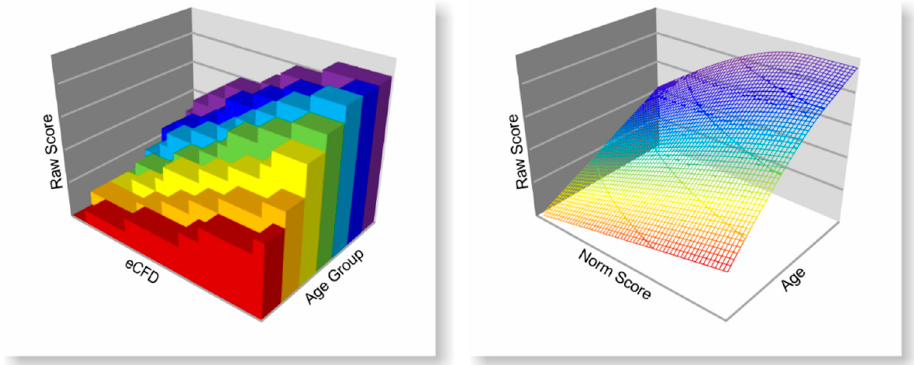
Figure 1. Visualisation of the norming approach as three-dimensional hyperplane fitting.